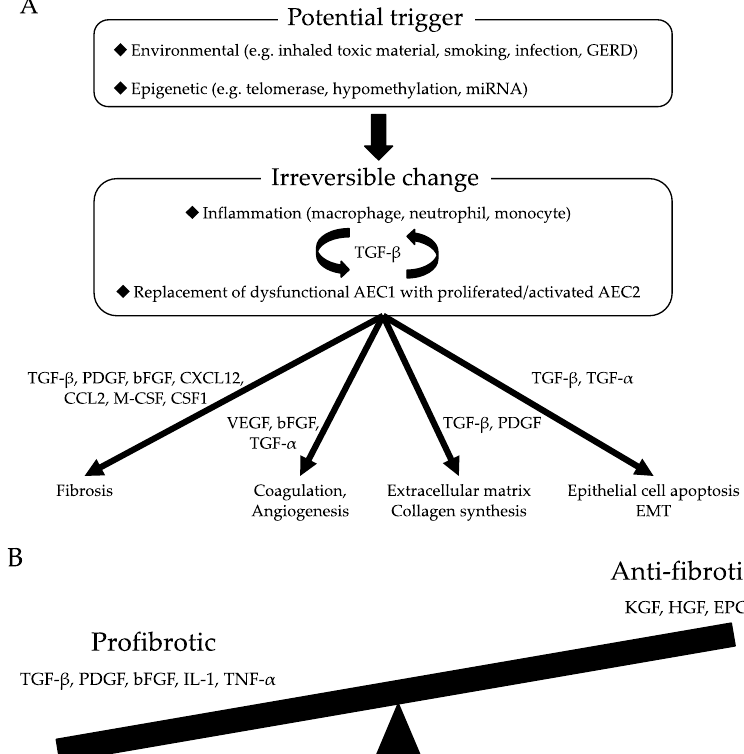
Figure 1. ( A ) Molecular mechanisms of pulmonary fibrosis; ( B ) Imbalance of profibrotic and antifibrotic mediators lead to defective regeneration and aberrant remodeling, resulting in the pathological transformation of pulmonary fibrosis. GERD, gastroesophageal reflux disease; AEC, alveolar epithelial cell; EMT, epithelial mesenchymal transition; EPC, Endothelial progenitor cell.